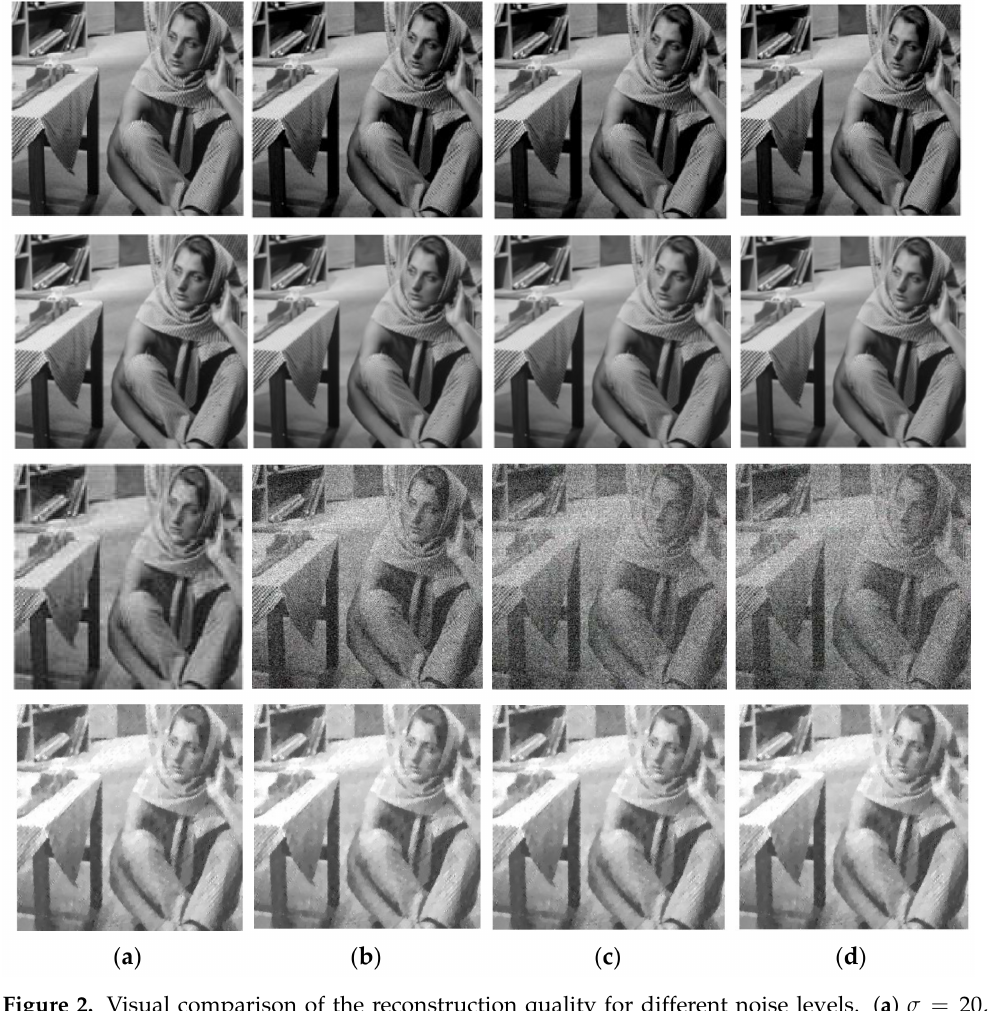
Figure 2. Visual comparison of the reconstruction quality for different noise levels. ( a ) σ = 20, ( b ) σ = 50, ( c ) σ = 60 and ( d ) σ = 80. The algorithms used are DCSR, GSR, wavelet denoising and NESTA: the denoised images are arranged in rows 1, 2, 3 and 4,